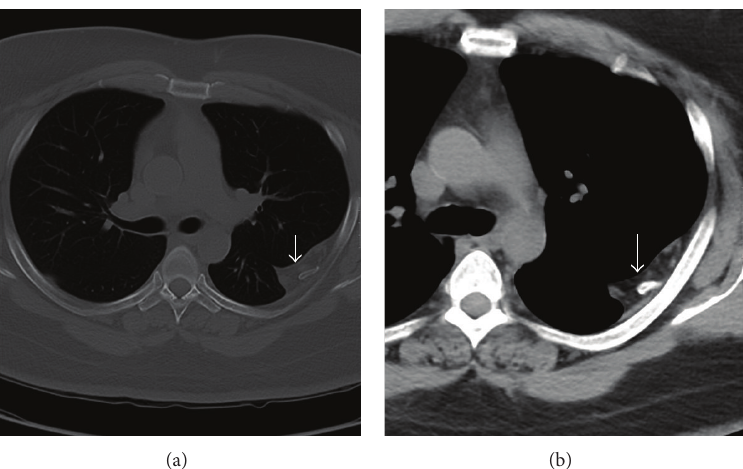
Figure 5: 43-year-old gentleman complaining of high grade fever, cough, and chest pain was investigated with chest radiographs and helical chest CT scan and subsequently diagnosed with intrathoracic ribs. Unenhanced axial chest CT scans with bone window in (a) and mediastinal window in (b) show prominent extrapleural soft tissue including fat around the left intrathoracic rib